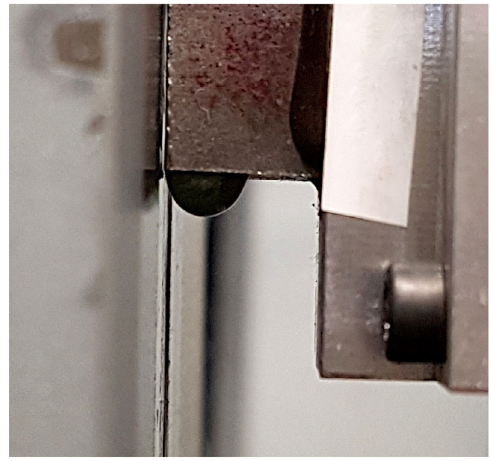
Fig. 8 Close-up of drop formation on the finely filed pin.